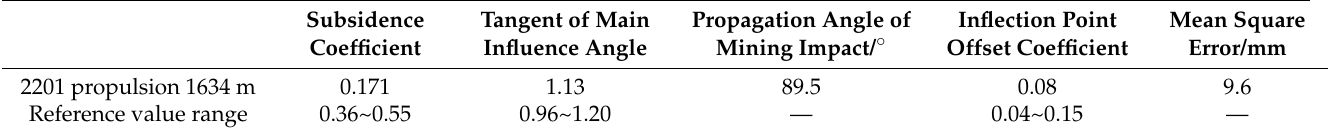
Table 1. Inversion results of strike line subsidence data when working face advances to 1634